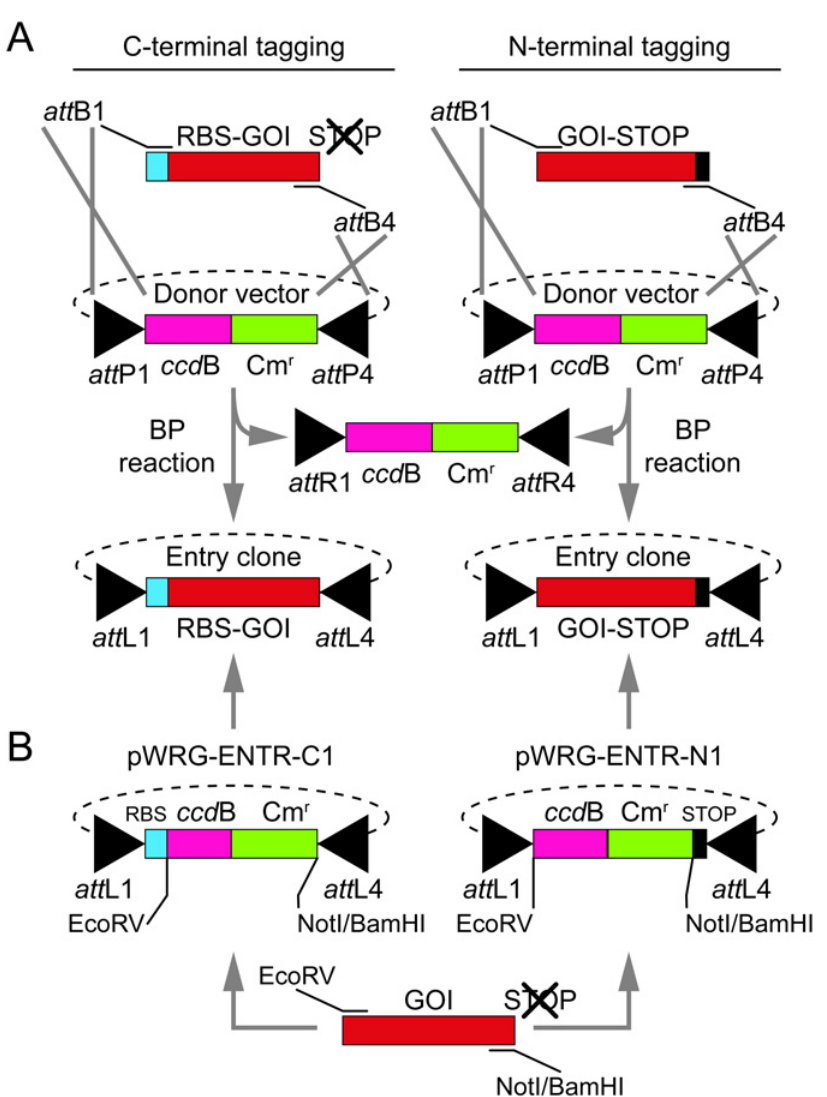
Fig 2. Generation of Entry clones. (A) Generation of Entry clones via BP reaction. The genes of interest (GOI, red) were amplified with flanking att B-sites and four terminal G ’ s (not shown). Depending on whether the GOIs should be fused N- or C-terminally to a reporter gene, the genes were amplified together with a ribosome binding site (RBS, turquoise) and no stop-codon (left) or without RBS and with stop-codon (right, black rectangle). Afterwards, the PCR products were recombined in a BP reaction with an appropriate pDONR vector yielding the desired Entry clones. (B) Generation of Entry clones via ‘ classical ’ cloning. The GOI is amplified with primers containing the flanking restriction enzyme recognition sites as indicated (bottom) and cloned in exchange with a ccd B-Cm r selection cassette into a custom-made Entry vector for C- (pWRG-ENTR-C1, left) or N-terminal (pWRG-ENTR-N1, right) reporter gene fusions, resulting in the desired Entry clone. Only the generation of att L1- att L4 Entry clones is shown. Construction of att L3- att L2 Entry clones follows the same principles, but alternative Entry- and Donor vectors and suitable primers have to be used (not